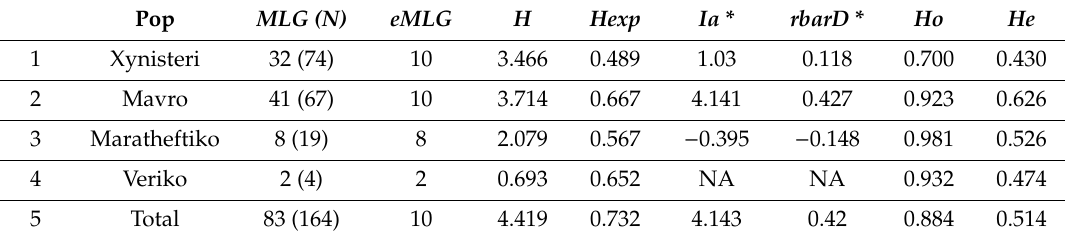
Table 1. Genetic variability across Cypriot grapevine populations. Total number of discrete genotypes and genetic diversity indices (clone corrected).